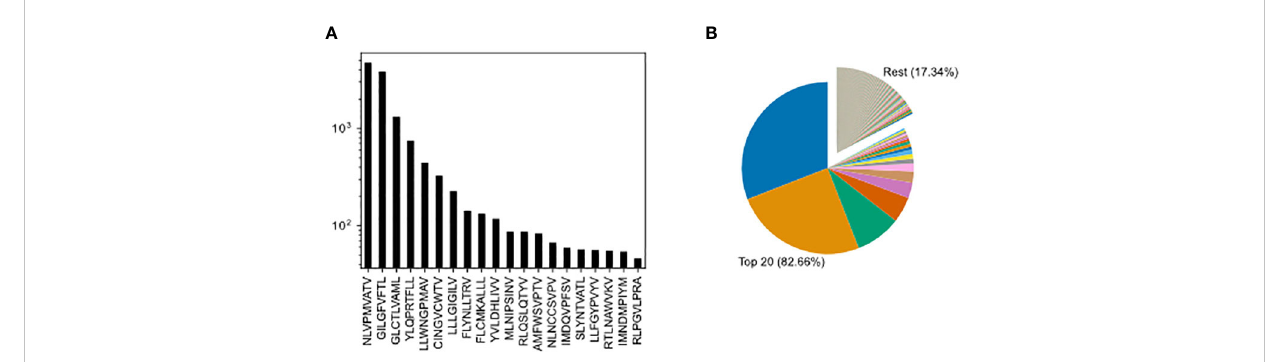
between the number of trainable parameters and performance of the model. We used a 1:1 ratio of positive:negative binding examples for both training and testing sets. The ROC-AUC score of each model on d base , except for ERGO with the embedding of long short-term almost all models predicted the outcome of a given TCR-pMHC pair better than random guessing. With the exception of ERGO with the LSTM embedding, no ROC-AUC score stood out and performances